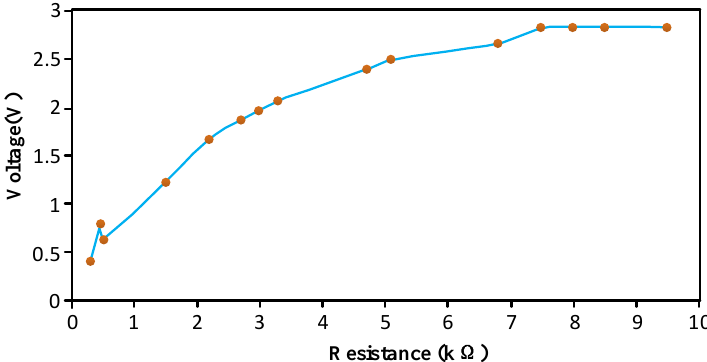
Figure 6. The experimental results of the relationship between the output voltage and resistance of the bubble sensor